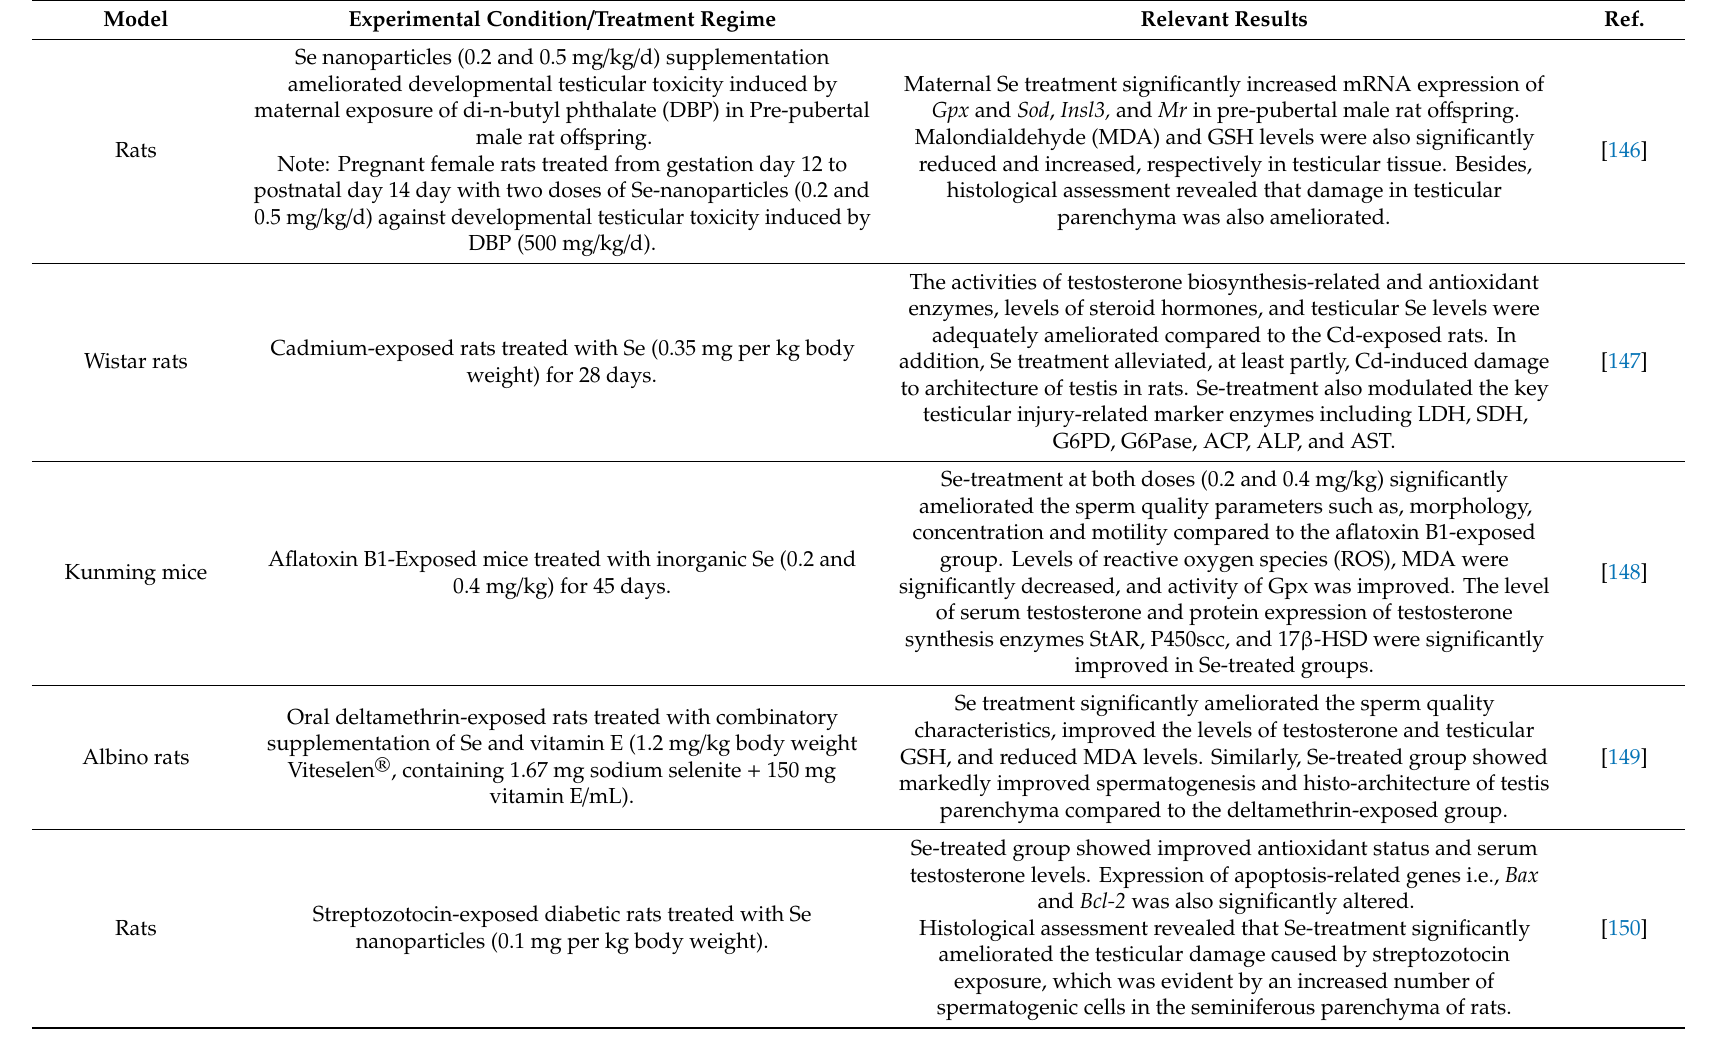
Table 6. Studies demonstrating the implication of selenium in ameliorating reproductive e ffi ciency in males exposed to di ff erent experimental / toxicity